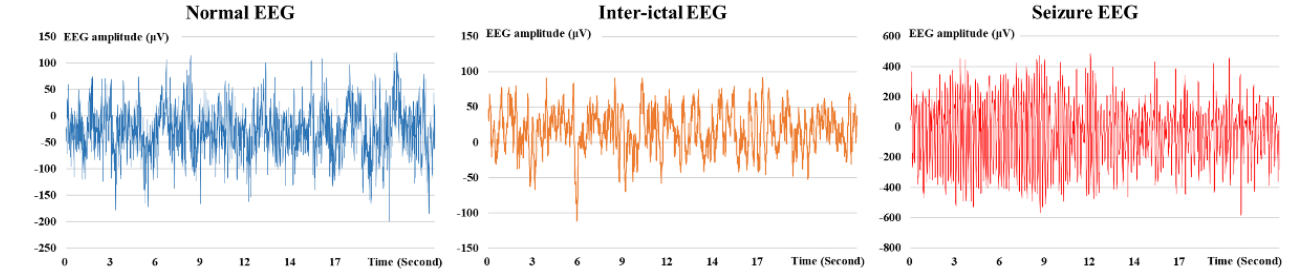
Figure 1. Samples of normal, interictal, and seizure EEG signals from the Bonn University data set.